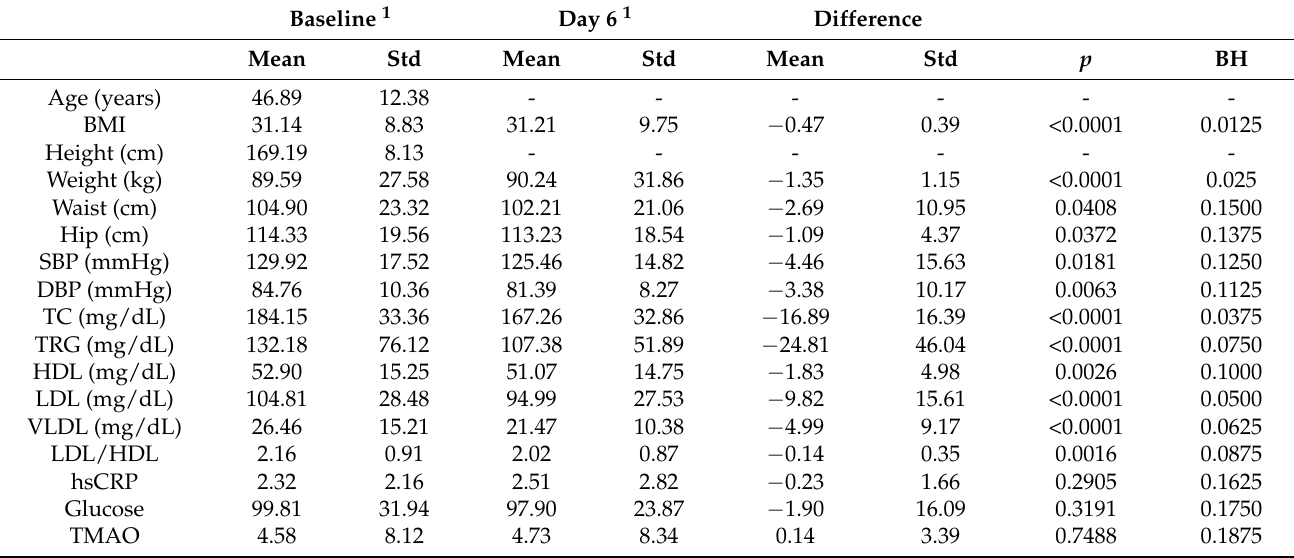
Table 1. Demographics and difference in clinical variables over time. Systolic blood pressure, SBP; diastolic blood pressure, DBP; total cholesterol, T; triglycerides, TRG; high density lipoprotein, HDL; low density lipoprotein, LDL; very low density lipoprotein, VLDL; high-sensitivity C-reactive protein, hsCRP; trimethylamine N-oxide, TMAO; body mass index, BMI; standard deviation, Std; Benjamini-Hochberg critical value, BH.